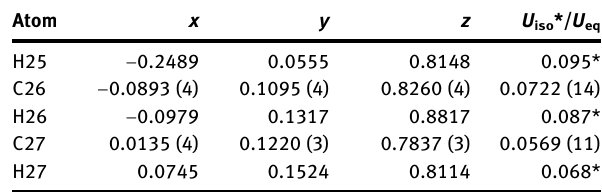
position of the distorted octahedral geometry of the Fe2